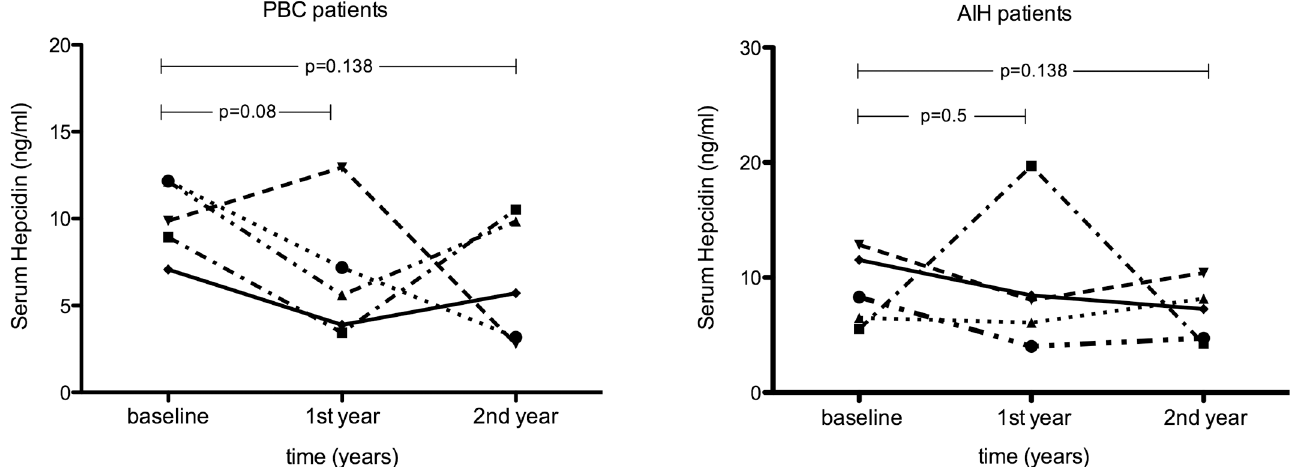
Fig 2. Serum hepcidin levels in patients with autoimmune liver diseases during treatment. Serum hepcidin levels in patients with PBC ( n = 5, left panel) and AIH ( n = 5, right panel) during a two-year treatment. P values calculated using Wilcoxon Signed-Rank